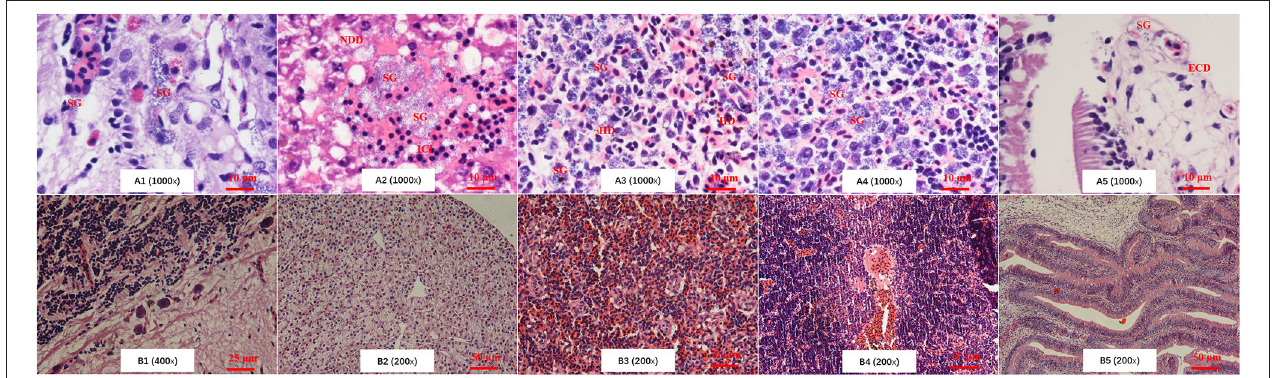
FIGURE 2 | The histopathological changes of tilapia infected with GBS. A1–A5 and B1–B5 showed the histopathological results of brain, liver, spleen, kidney, and gut from tilapia injected with GBS or with PBS, respectively. There was no pathological damage in tissues from tilapia infected with PBS. SG, Streptococcus granules,